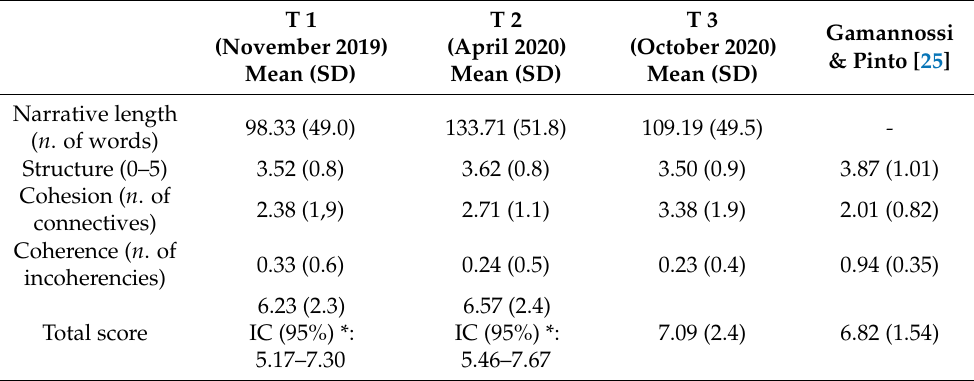
Table 1. Means and standard deviations of the narrative skills measures obtained in the SSG at the three observation times; comparison with the data reported by Gamannossi & Pinto [25] in a sample of 80 children of grade II of a primary